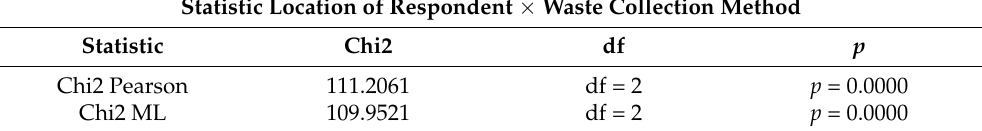
Table 4. Chi-square statistics and its components taking into account the location of the respondents and waste collection methods.